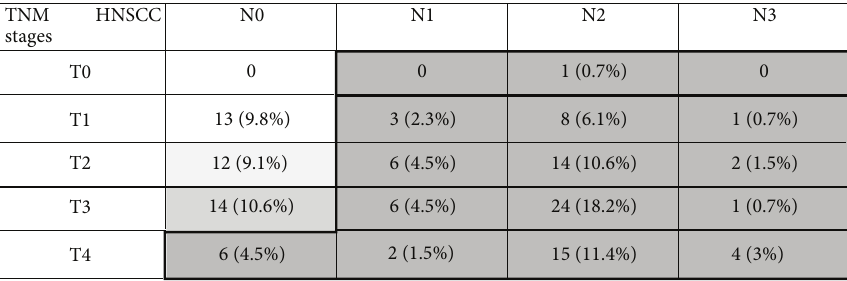
Figure 2: Tumor staging of head and neck cancer according to TNM classification. Stage I: T1N0M0; stage II: T2N0M0; stage III: T3N0M0; stage IV: T4N0-3M0.